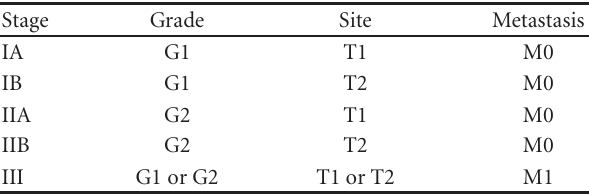
Table 1: The Enneking system for the surgical staging of bone and soft-tissue tumors is based on grade (G), site (T), and metastasis (M)